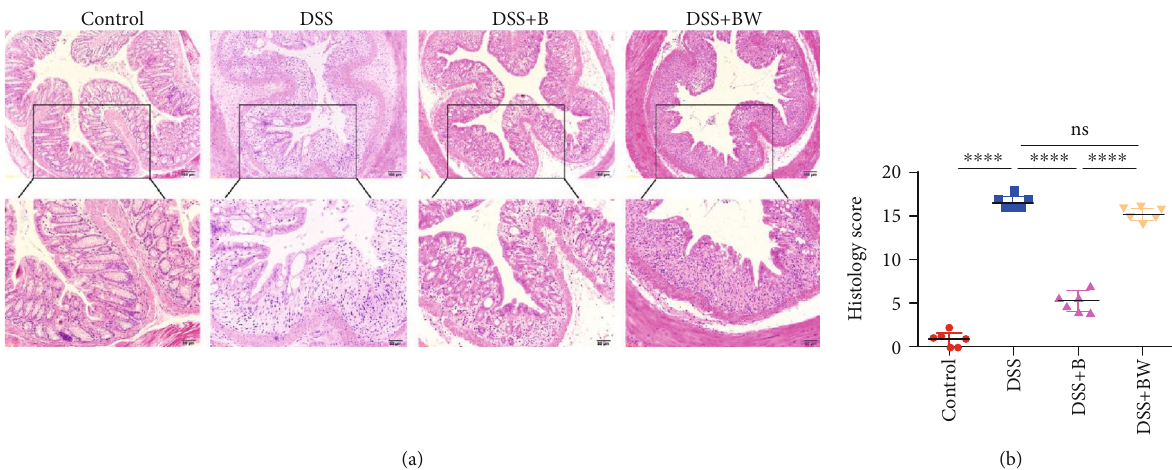
Figure 4: E ff ect of Wogonin on colon damage in mice induced by DSS. (a) Colon sections were stained with hematoxylin and eosin (H&E) (magni fi cation × 100/200). (b) Histological score of colon tissues was assessed ( n = 6 per group). ∗∗∗∗ P < 0 : 0001 ; ns: no signi fi